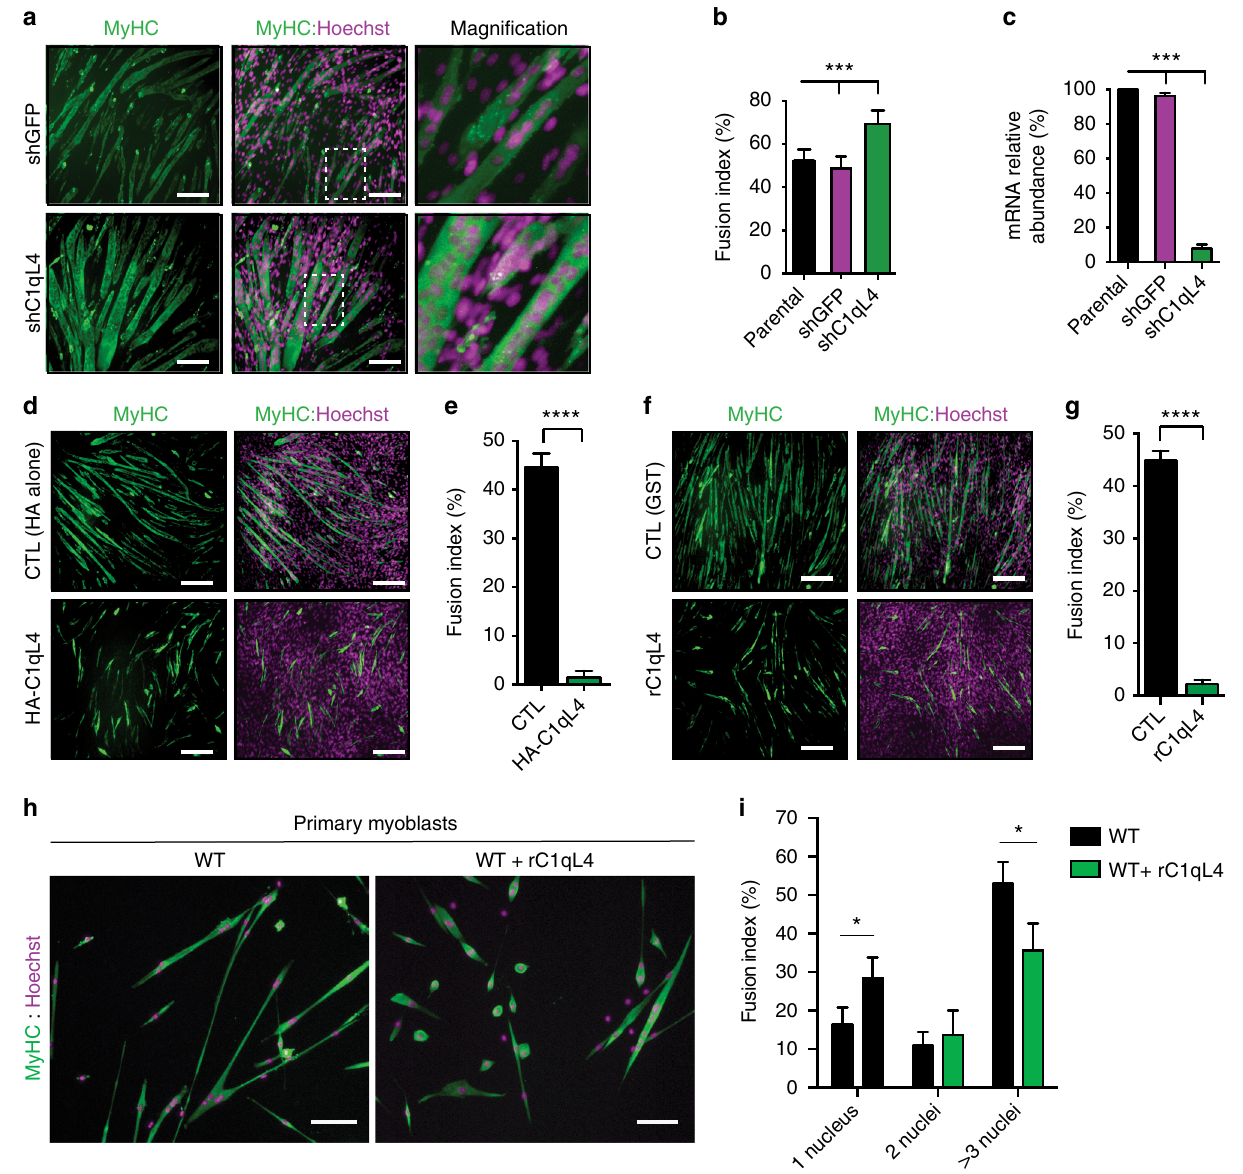
Fig. 2 C1q-Like proteins negatively regulate myoblast fusion. a Downregulation of C1qL4 increases myoblast fusion after 48 h of differentiation. Dotted white boxes are shown at higher magni fi cation in the right panels. b To quantify myoblast fusion, MyHC-positive cells with three nuclei or more were considered as multinucleated myo fi bers and the fusion index was calculated by dividing the number of nuclei in multinucleated fi bers by the total number of nuclei for each described condition. Quanti fi cation of experiment shown in a . c Real-time Q-RT-PCR ampli fi cations of C1ql4 were performed to con fi rm the speci fi c shRNA-mediated knockdown. d – g Plasmid-mediated expression of HA-C1qL4, or addition of recombinant C1q domain of C1qL4 (rC1qL4), blocks C2C12 myoblast fusion. d , f Representative images of myoblast fusion from the indicated condition. e , g Quanti fi cation of experiments shown in d and f . h Addition of rC1qL4 blocks myoblast fusion of primary mouse myoblasts (72 h differentiation). i Quanti fi cation of experiments shown in h . Myo fi bers were stained for Myosin Heavy Chain (MyHC, MF20 antibody (green)) and nuclei were revealed by Hoechst (purple). Error bars indicate standard deviation. Scale bar = 100 μ m (C2C12), scale bar = 50 μ m (primary myoblasts). One-way ANOVA followed by a Bonferroni test was used to calculate the P- values; * P < 0.05, *** P < 0.001, **** P <